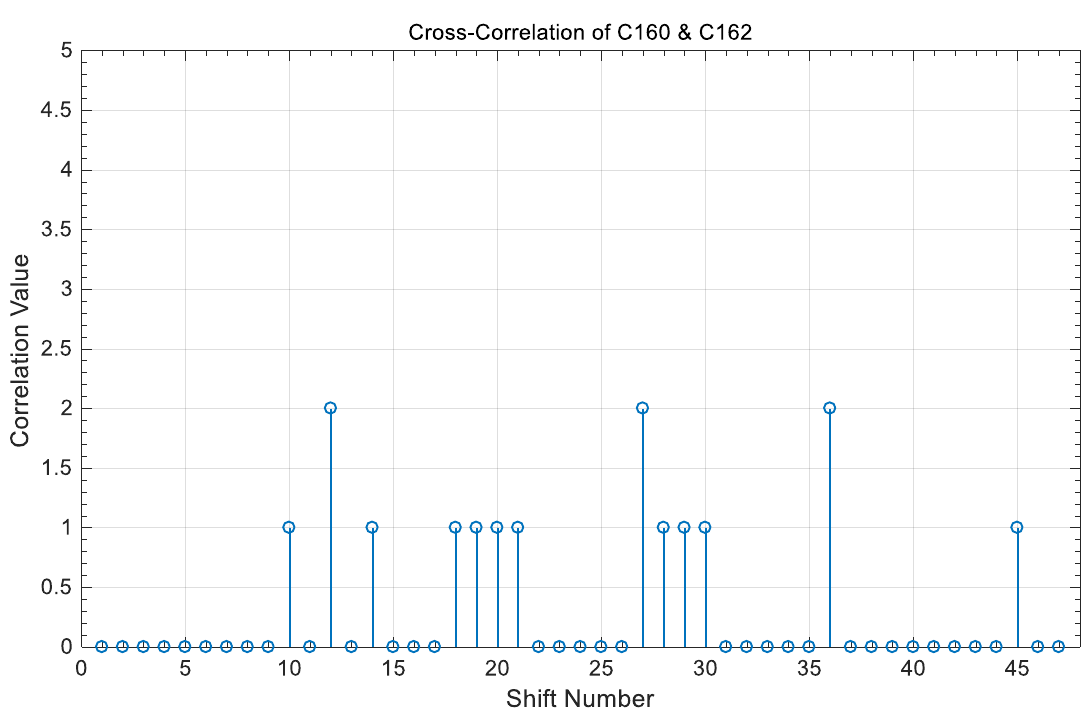
Figure 12. Cross-correlation between 𝐶 160 and 𝐶 162 sequences in same group, 𝑃 1 = 5 and 𝑃 2 = 7 .